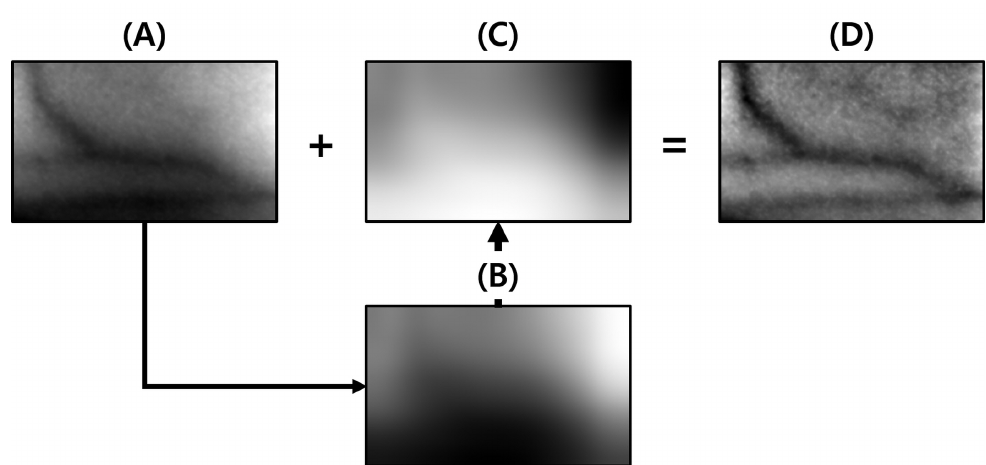
Figure 10. ( A ) is the original image, ( B ) is the background approximation by blurring, ( C ) is the inverted image of ( B ), and ( D ) is the background approximation based on summing ( A , C ) resulting an image with the lighting removed.